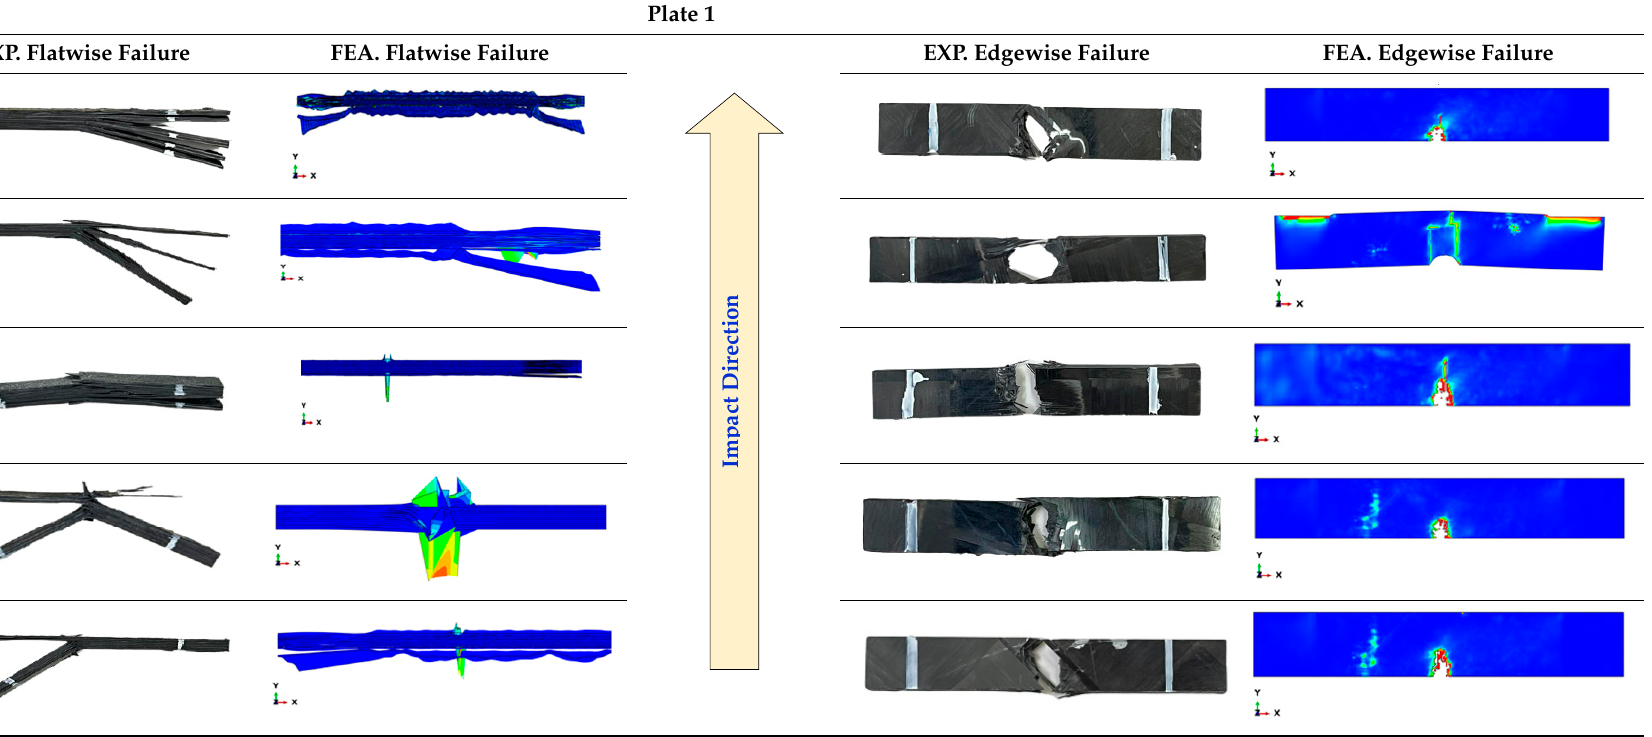
Table 3. Failure modes of Plate 1 under Charpy impact test conditions.